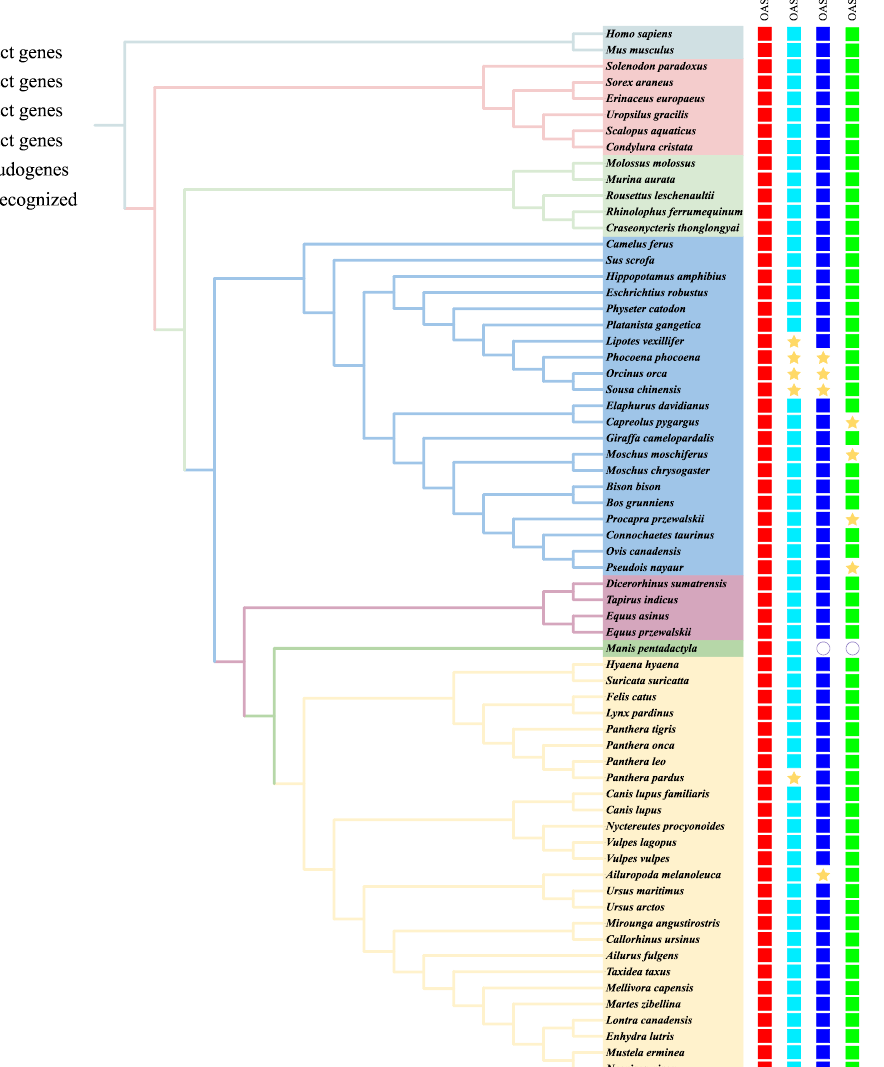
Figure 1. Species tree for the animals used in this study and the intact OAS gene number in these animals.